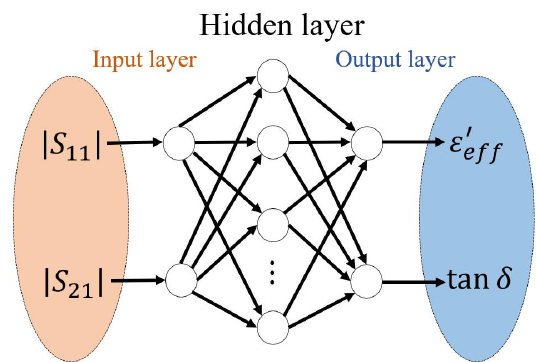
Figure 5. BP neural network structure. Table 2. Parameters of BP neural network.